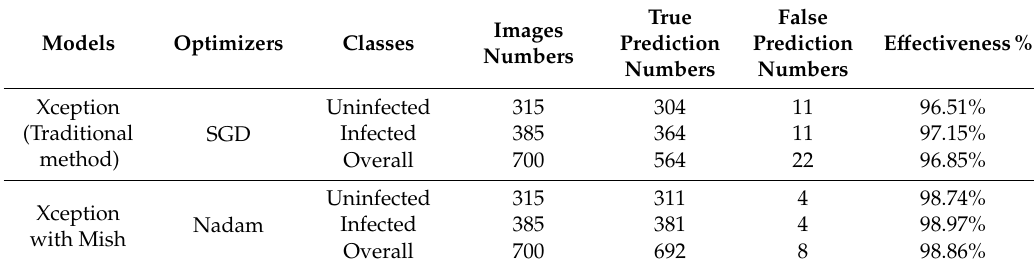
Table 11. The effectiveness of CNN model testing by using Xception with Nadam and Mish. Table 11. The e ff ectiveness of CNN model testing by using Xception with Nadam and Mish.